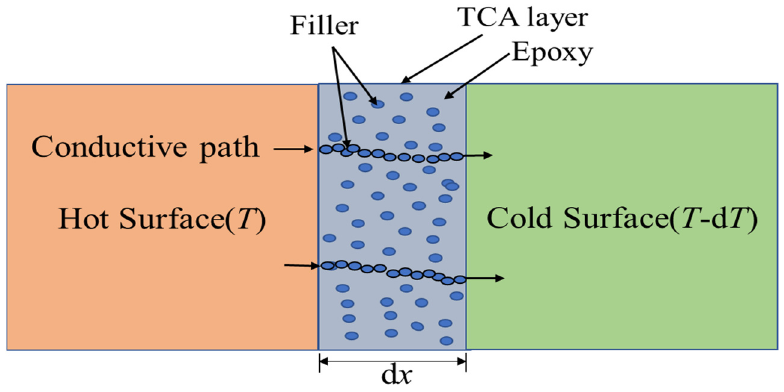
Figure 4. Heat conduction mechanism of TCA.